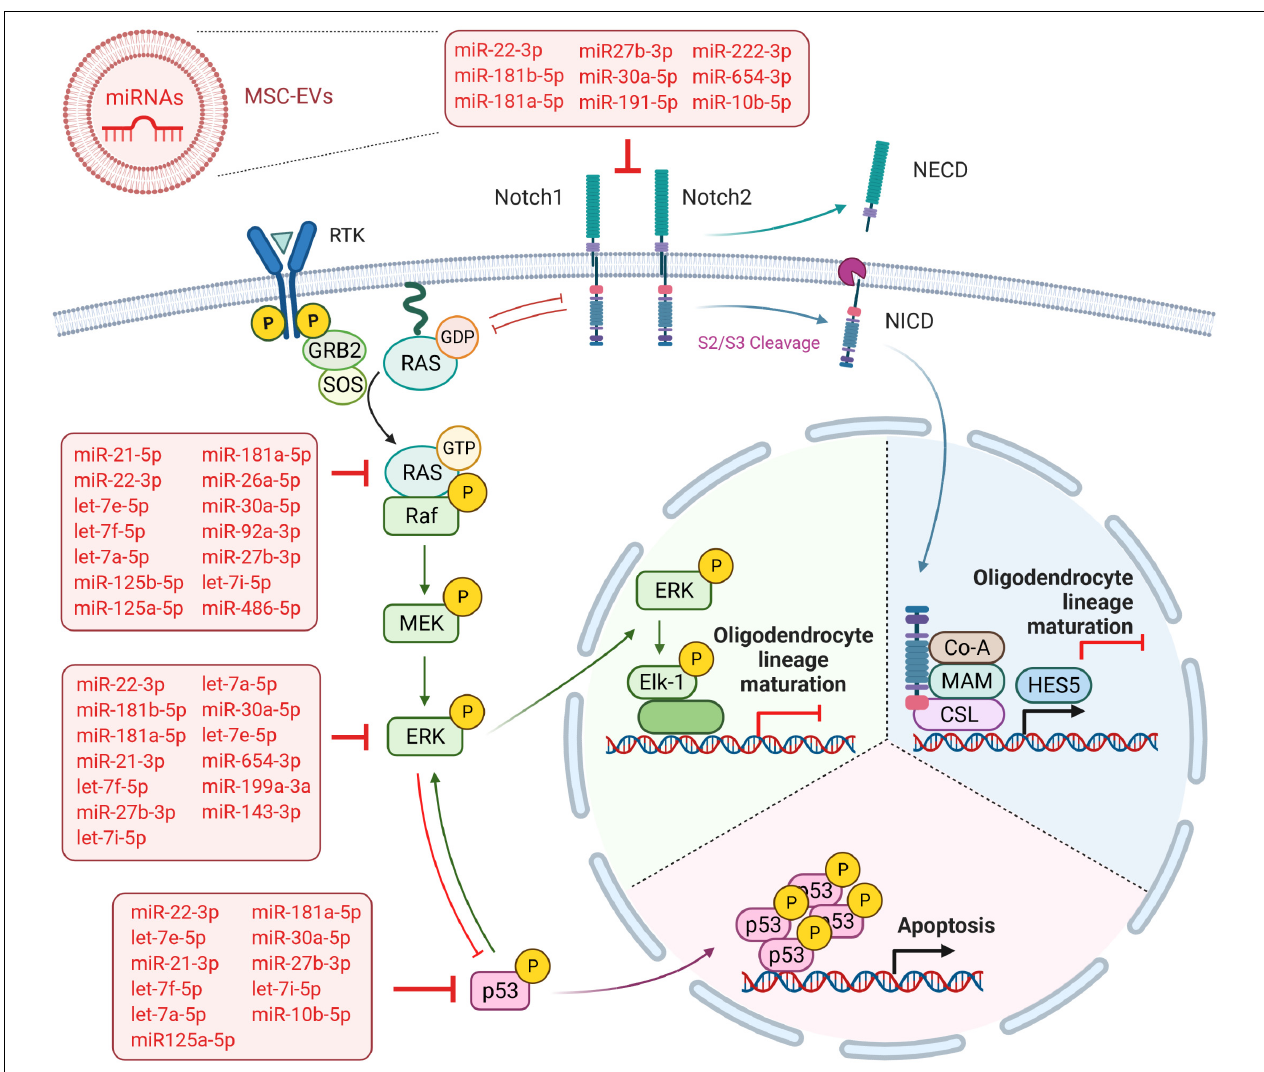
FIGURE 6 | Overview summarizing the predicted targets of WJ-MSC-derived sEV miRs in the Notch and MAPK/ERK signaling cascades. Created with BioRender.com.